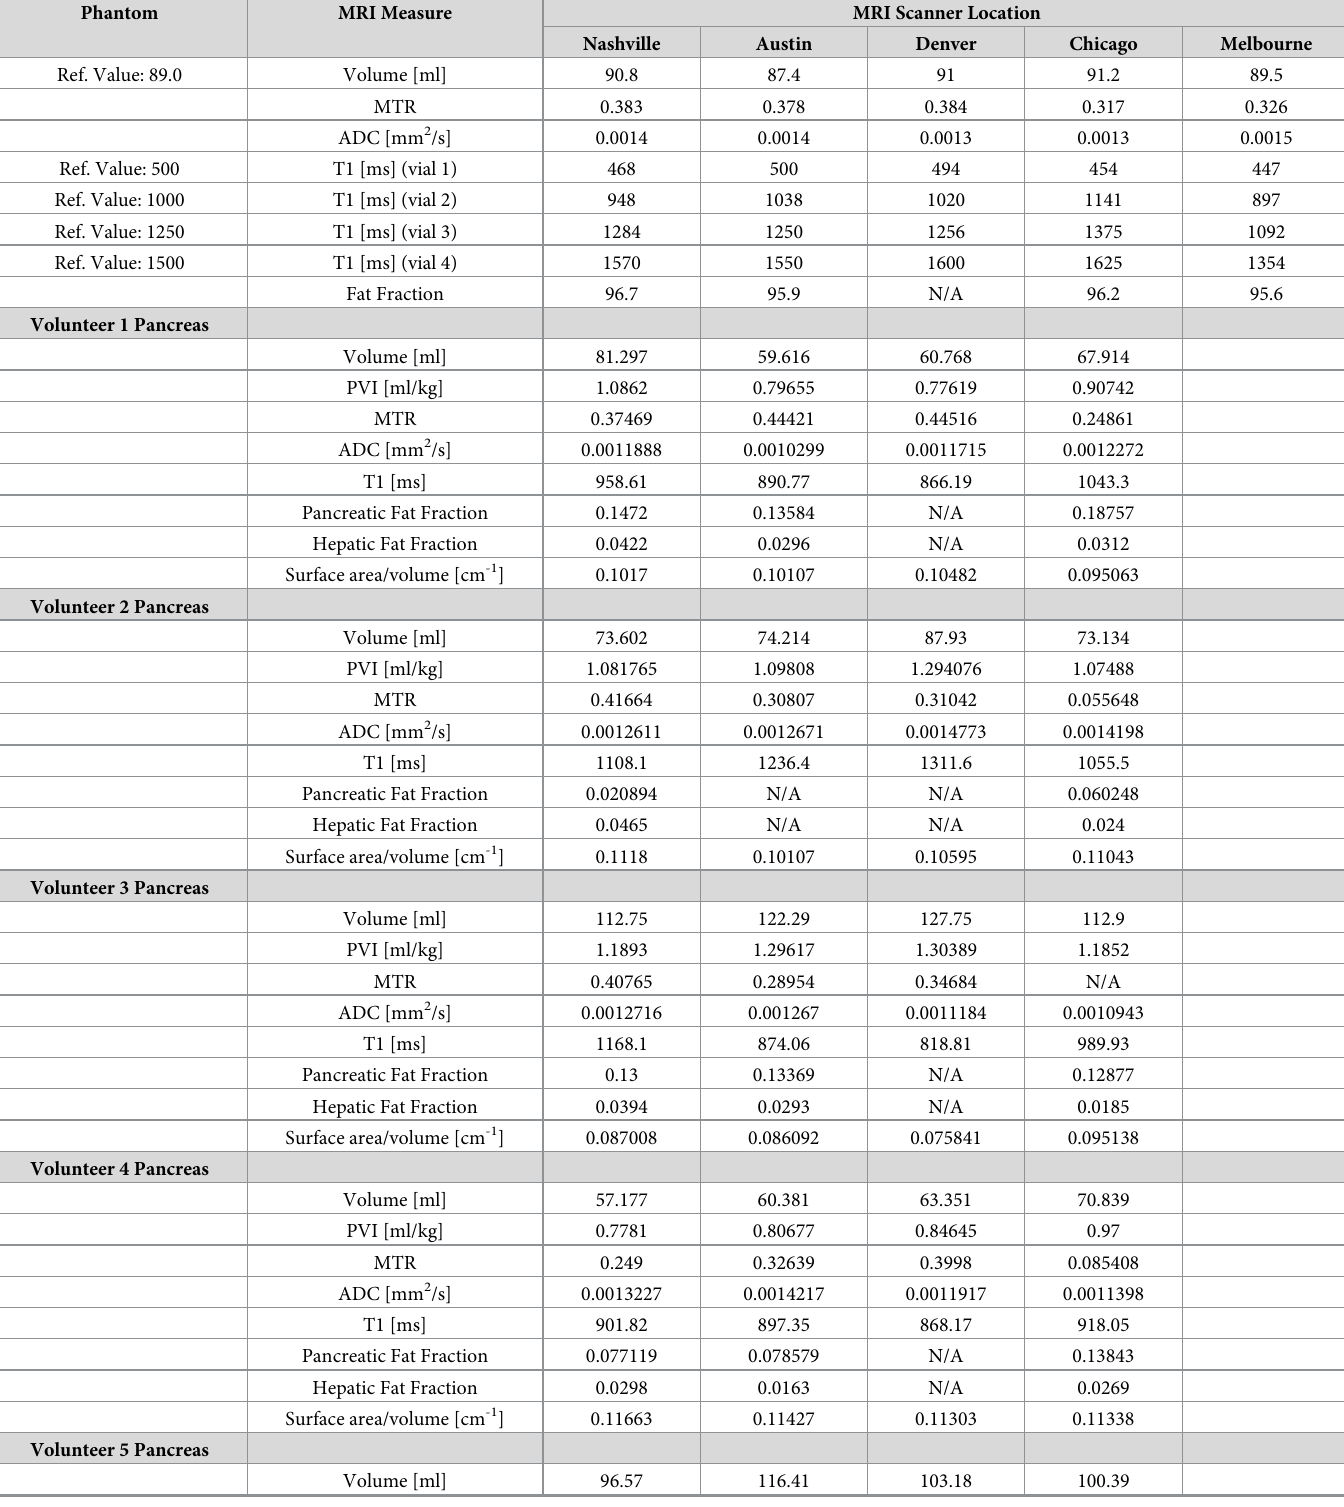
Table 2. MRI reproducibility